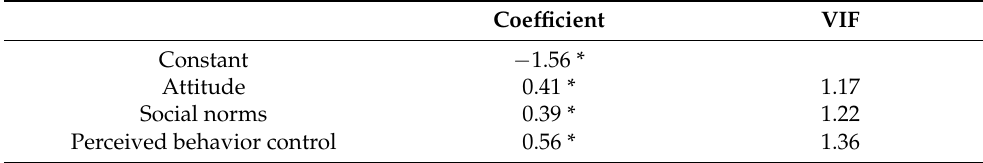
Table 6. Predictors of behavioral intention to use